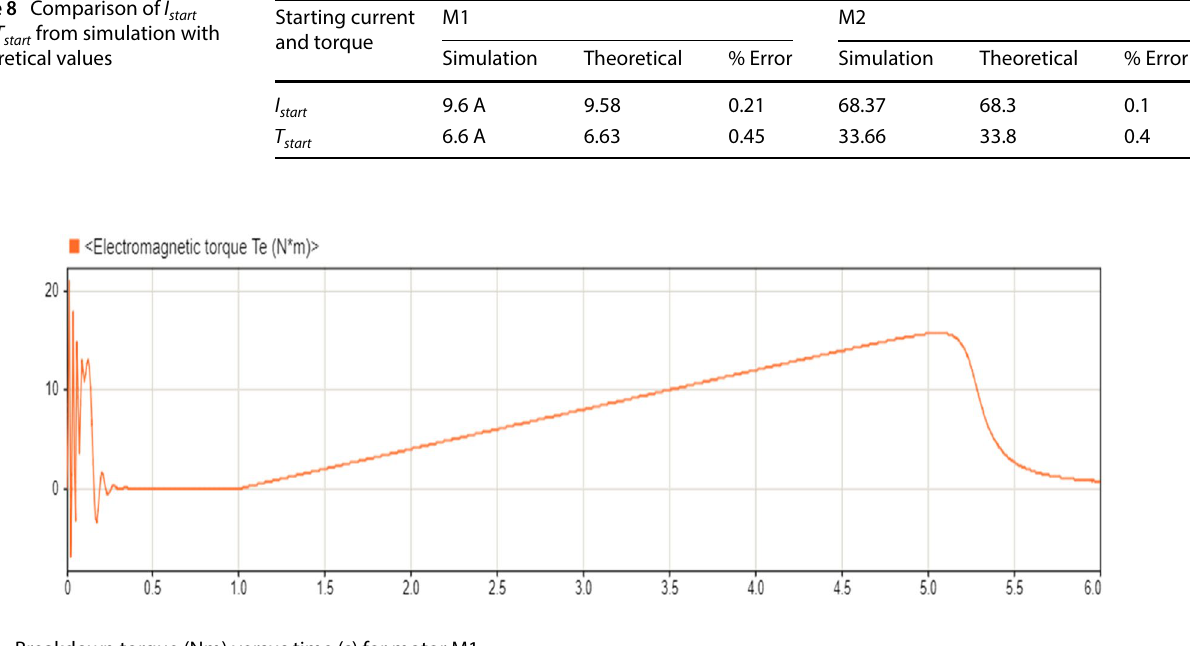
Table 8 Comparison of I start and T start from simulation with theoretical values